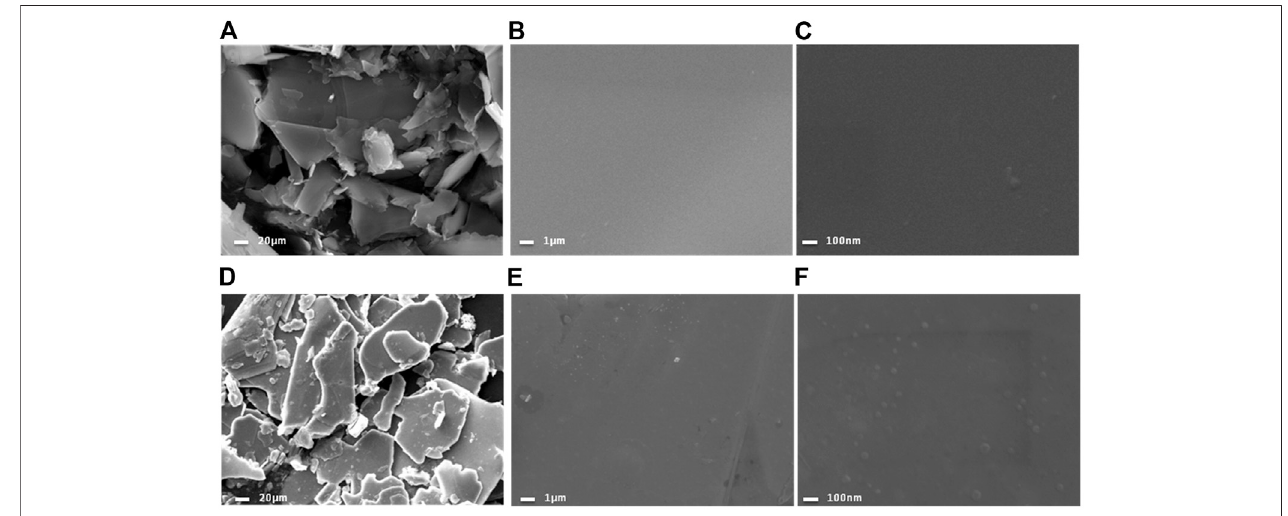
FIGURE 3 | SEM images of (A – C) calcinedNiCl 2 and (D – F) reduced Ni-NiCl 2 .